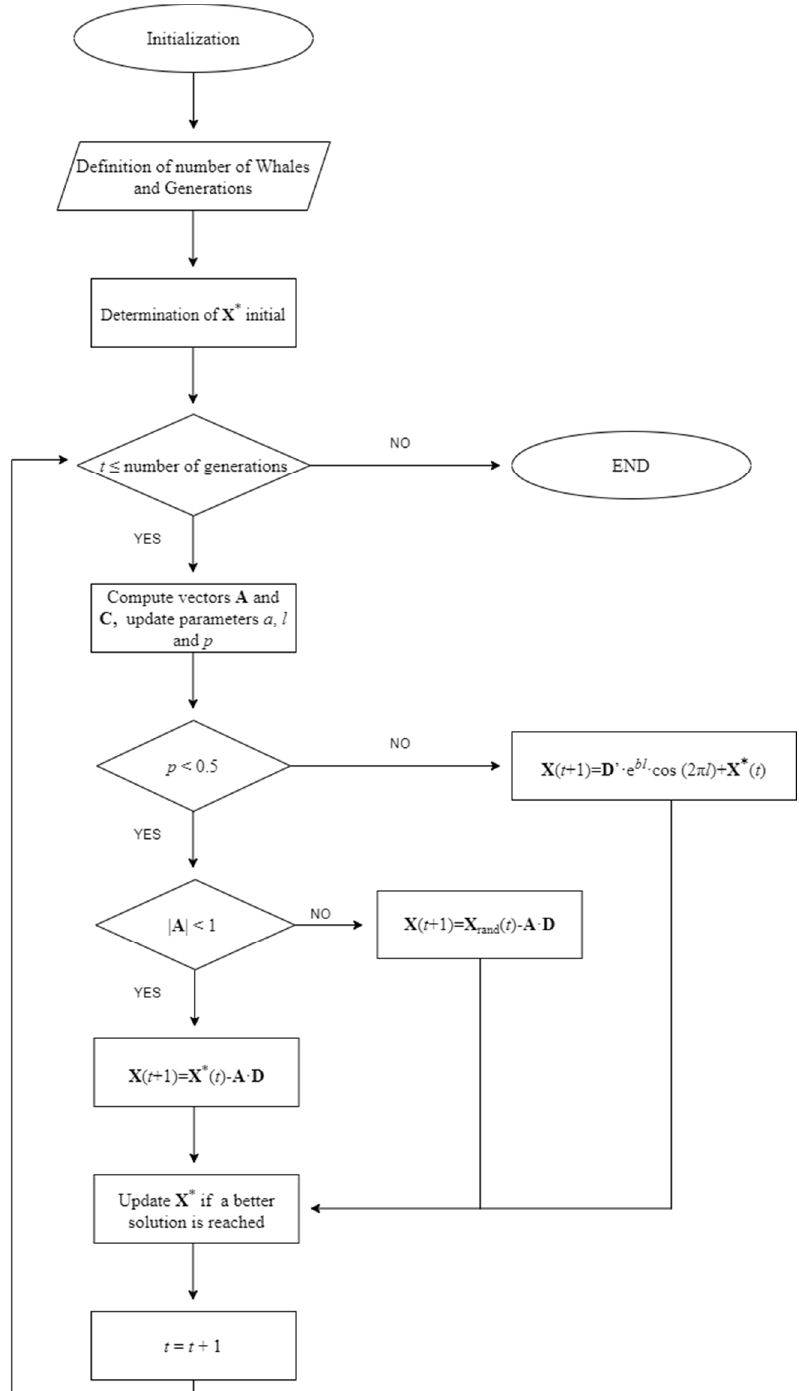
Figure 2. Description of the WOA procedure.